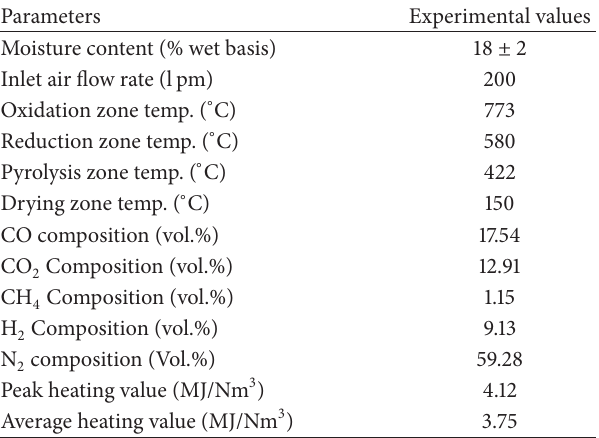
Table 3: Gasification